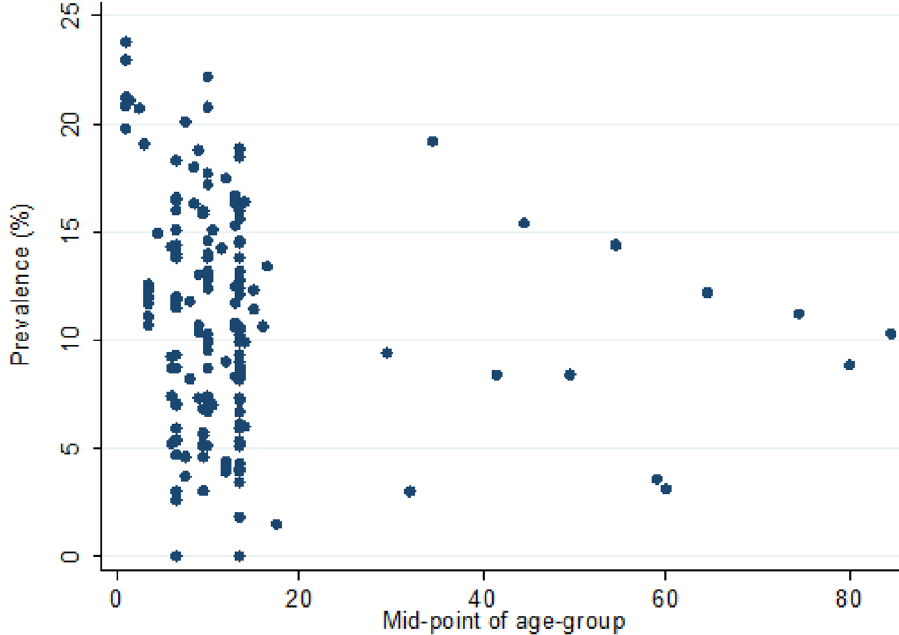
Figure 3. 12-month prevalence of AD across age groups.